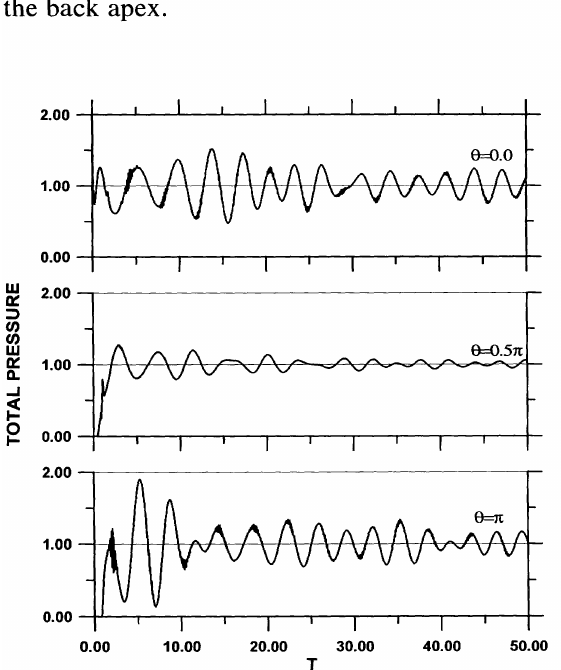
FIGURE 14 Time histories of IT(1, 0, T) for 0.0 :5 T:5